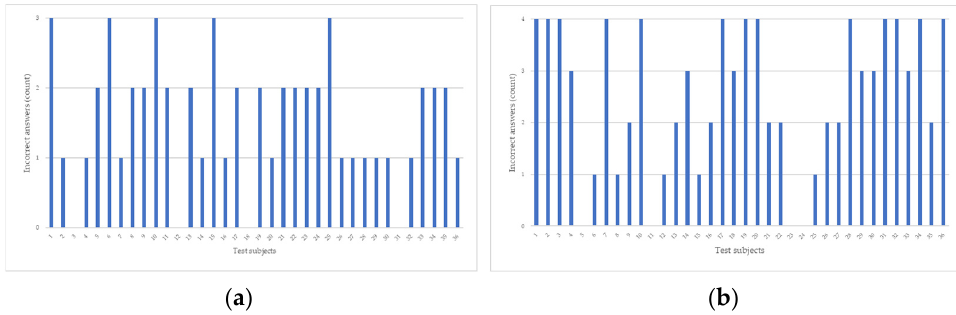
Figure 5. Distribution of incorrect answer (count) based on XAML ( a ) and classic C# ( b ).